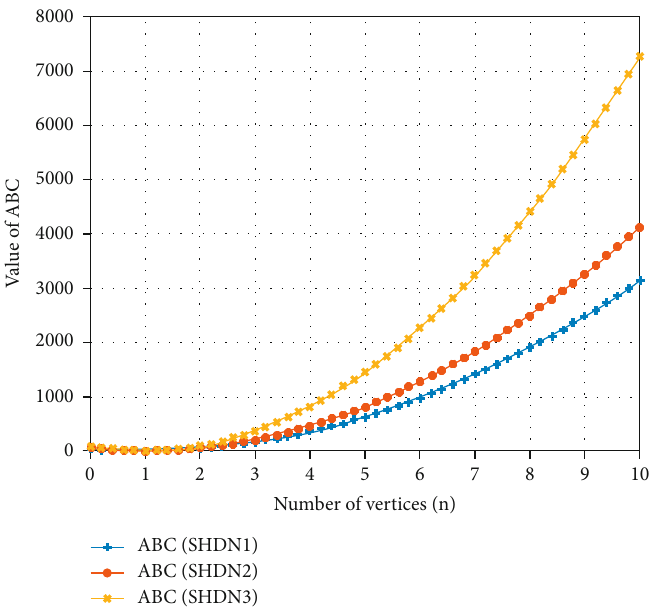
n Þ , Γ n Þ , and Γ n Þ using 2D graphs of ABC index AZI. 1 ð 2 ð 3 ð